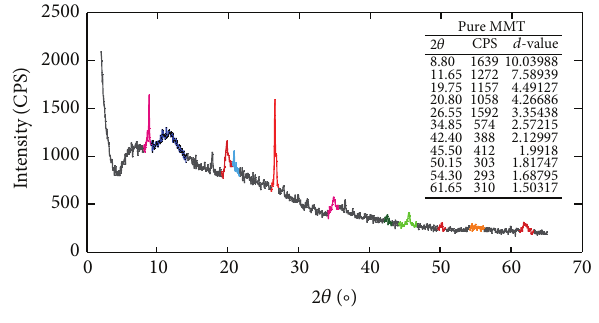
Figure 3: XRD scan of pure MMT.